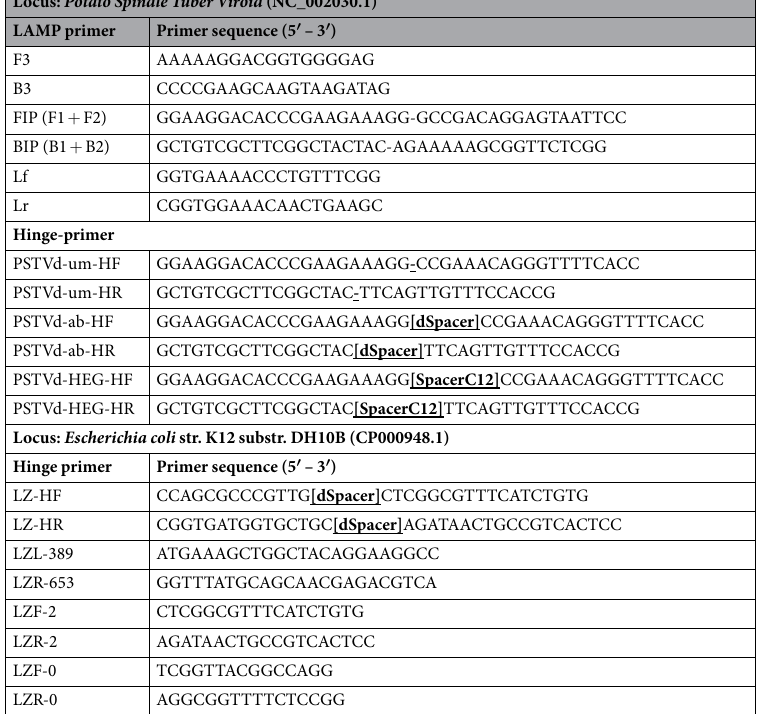
Table 1. Overview of LAMP- and Hinge-primer for detection of PSTVd and beta-gal ( E.coli ). The bold letters in the sequence denotes the location of the blocking modification (um: unmodified, ab: dSpacer and HEG: SpacerC12). For the detection of PSTVd two modifications and a control were used: dSpacer (abasic furane), c12-Spacer (hexaethyleneglycol) or no modification. For the detection of E.coli , only the dSpacer was used. All oligonucleotides were HPLC purified.